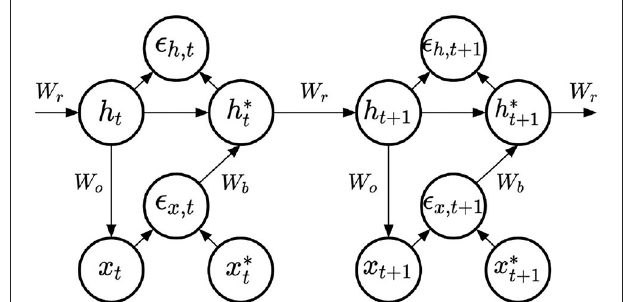
FIGURE 3 | PC-RNN-V